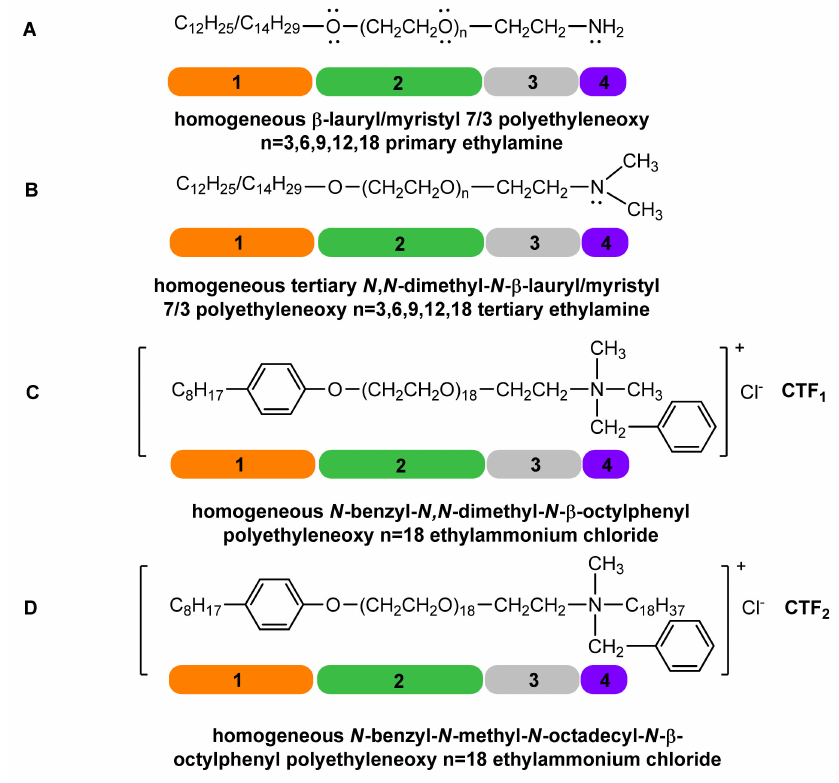
Figure 5. The functional structuring of homogeneous higher primary and tertiary alkyl polyetheramines ( A , B ) [30–32] and of certain phase-transfer catalysts (CTF 1 ; CTF 2 ) ( C , D ) [33]. 1—nonpolar hydrophobic group; 2—nonionic polar hydrophilic group; 3—connecting nonpolar hydrophobic group; 4—cationic polar hydrophilic